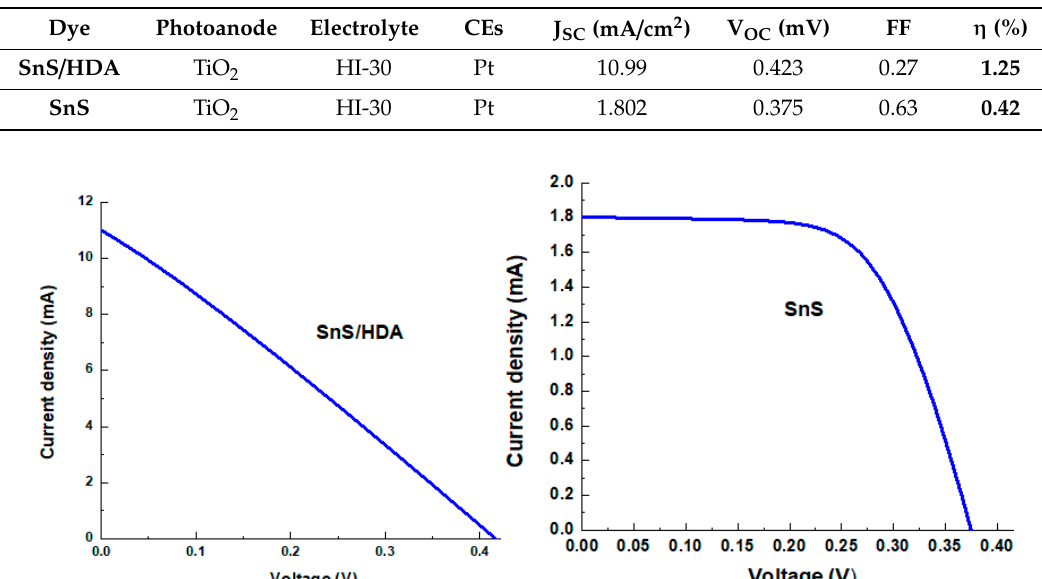
Table 1. I–V characteristics of SnS/HDA and SnS nanoparticles.